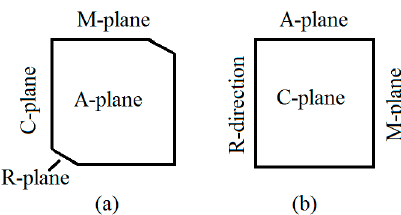
Figure 1. Schematic of the orientation of ( a ) A-plane and ( b ) C-plane sapphire crystals.